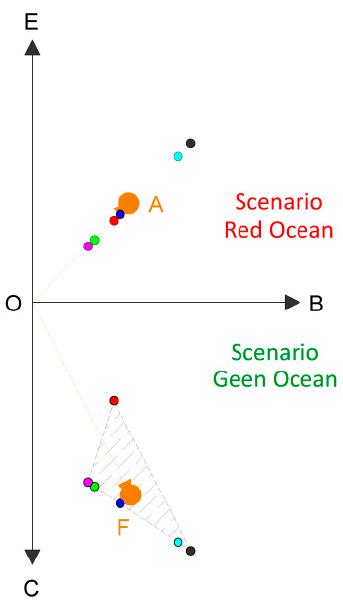
Figure 6. Visualization of development factor coordinates for the Red Ocean and the Green Ocean. Source: own calculation. The designations O, E, B and C are as shown in Figure 3.